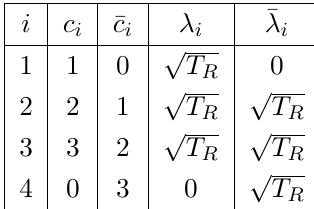
Table 1 . The colour index speci(cid:12)cations for the four partons in (cid:12)gure 2, which correspond to n =